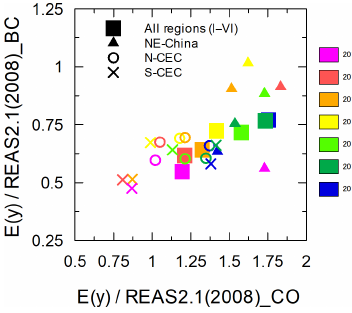
Figure 9. Relationship between trends in black carbon (BC) and CO emissions estimated by this study. Emissions correction factor – E( y )/REAS2.1(2008); NE China – northeastern China; N-CEC – north-central East China; and S-CEC – south-central East China.